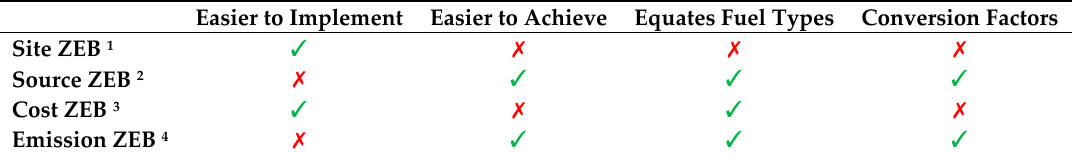
Table 1. Definition approaches for